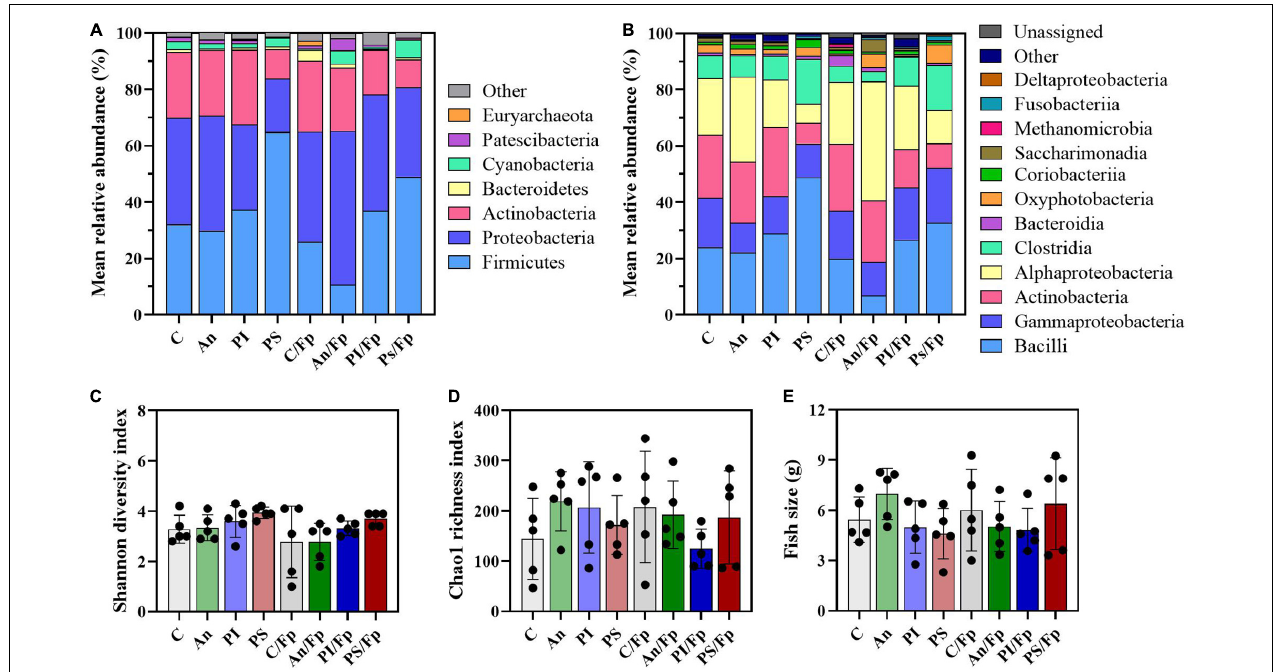
FIGURE 11 | Microbial community 33 dpi. Characterization of mean relative abundance at phylum (A) and class (B) level, Shannon diversity index (C) , Chao1 richness index (D) and fish weight (E) . Values represent the mean of five samples. In (C,D) , error bars represent the standard deviation. Shannon diversity index values are based on 10,000 reads per sample. C, control feed group; An, antibiotic feed group; PI, phage-immobilized feed group; PS, phage-sprayed feed group; C/Fp, control feed group + F. psychrophilum ; An/Fp, antibiotic feed group + F. psychrophilum ; PI/Fp, phage-immobilized feed group + F. psychrophilum ; PS/Fp, phage-sprayed feed group + F. psychrophilum